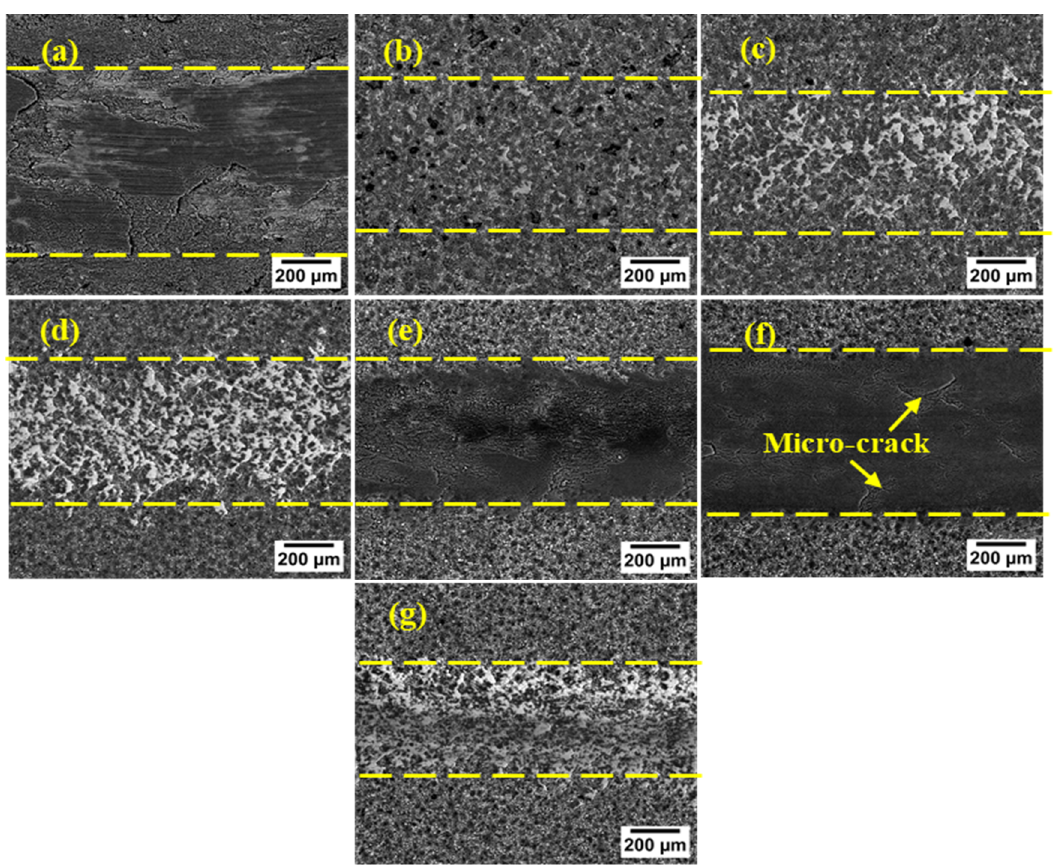
Figure 16. The SEM images of wear tracks after testing under 5 N normal load: ( a ) S1W, ( b ) S3W, ( c ) S5W, ( d ) S7W, ( e ) S9W, ( f ) S11W, and ( g ) S13W.